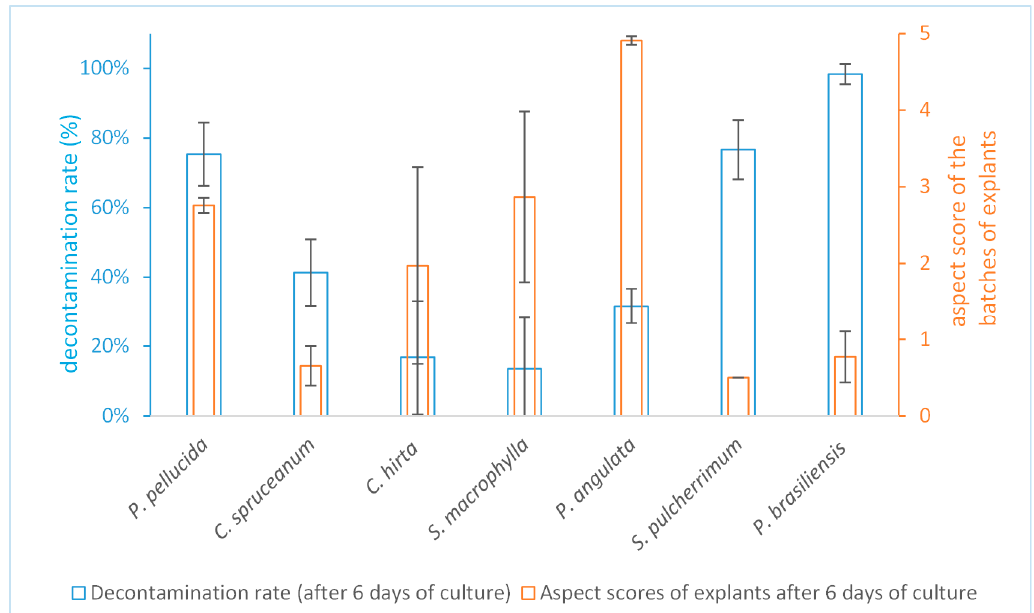
Figure 2. Evaluation of the e ffi ciency and impact of the surface sterilization procedure on the leaf’s explants (for each species, the procedure was realized on batches of 120 explants and repeated three